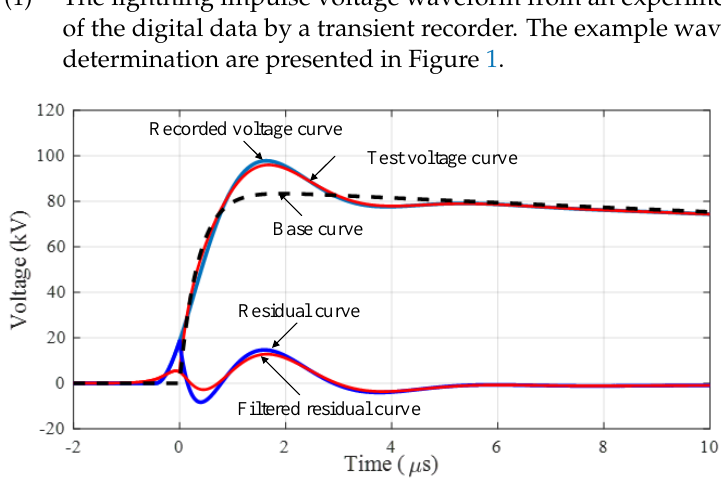
Figure 1. Voltage curves for determination of full lightning impulse voltage parameters. (2) From the digital waveform data, the offset voltage is determined and removed from the original recorded waveform. The waveform part utilized in the parameter deter- mination ranges from the voltage of 20% of the waveform peak on the front section to 40% of the waveform peak on the tail section. The selected waveform is referred to as the recorded curve. (3) The base curve parameters in Equation (1) or Equation (2) ( α , β , C , and t d or A , B , α , and β ) are determined by a curve fitting method. It is noted that in this paper the function in Equation (2) is selected as the base curve function for simplicity. The standards [1,2] recommend the Levenberg – Marquardt (LM) algorithm for the base curve parameter determination.